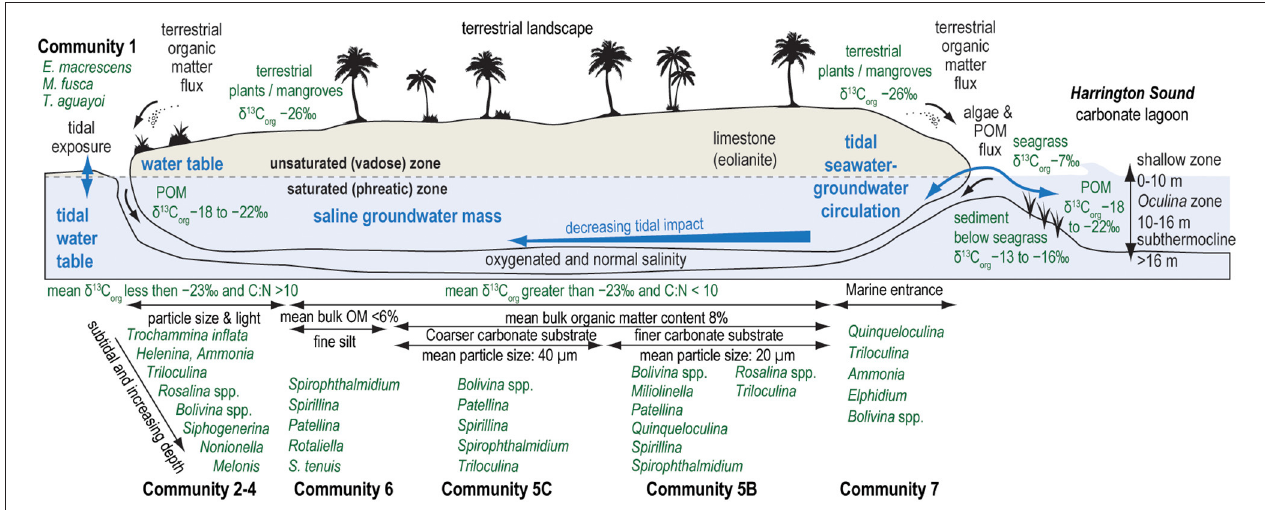
FIGURE 7 | Conceptual model of idealized benthic foraminiferal communities in the marine sector of karst subterranean estuaries in Bermuda, along with idealized changes in stable carbon isotopic value of bulk organic matter ( δ 13 C org ), organic matter quantity, mean particle size of substrate, tidal exposure in subaerial pools, and the magnitude of nutrient and particle delivery from ocean-groundwater exchange through marine cave openings. Representative values of δ 13 C org values for source organic matter summarized from the literature (Goericke and Fry, 1994; Kennedy et al., 2010; Fourqurean et al., 2019), and ecological zones in Harrington Sound from Neumann